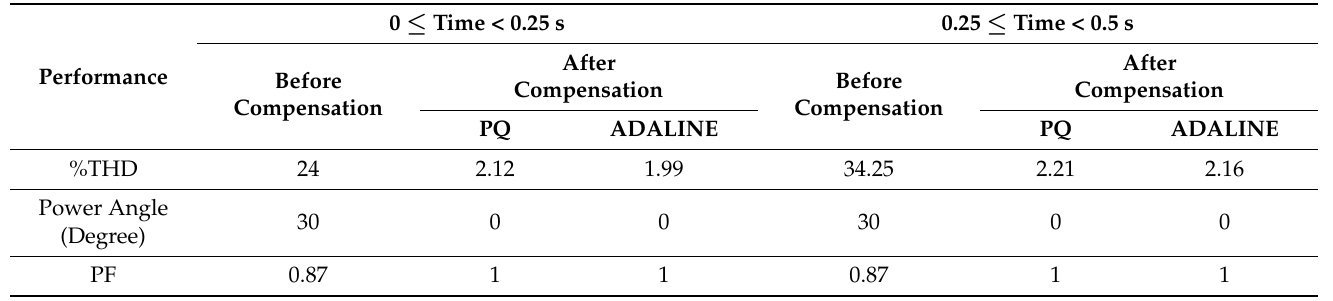
Table 2. The average performance value for Case 1.